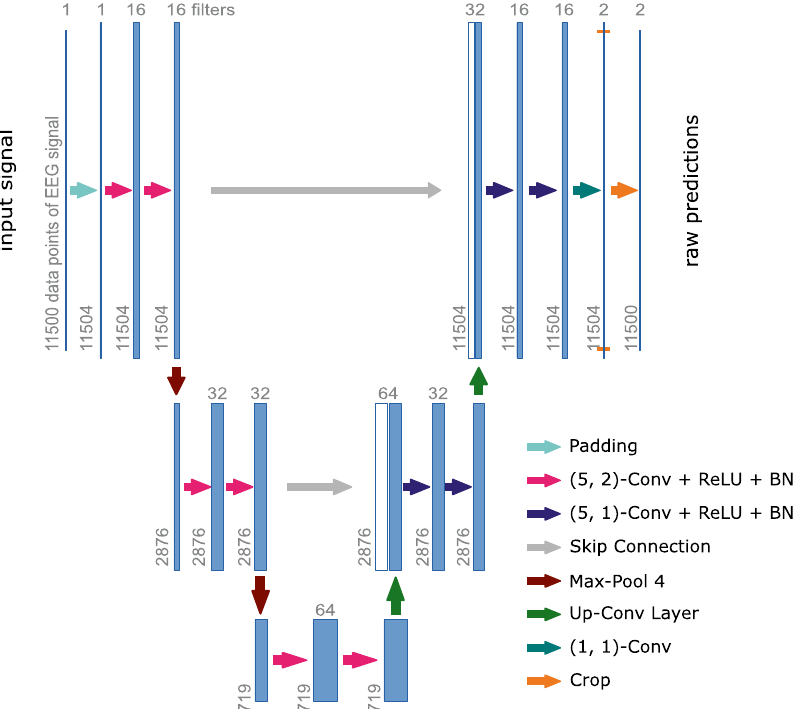
Figure 1. Architecture of the SUMO model. Each box represents a feature map with the number of filters given on top. The operations conducted are represented by the colored arrows. Convolutions are described using the format (k, d)-Conv with k denoting the kernel size and d the dilation size. ReLU: rectified linear unit; BN: batch normalization. Up-Conv Layer: nearest-neighbor upsampling with factor 4 followed by a (4,